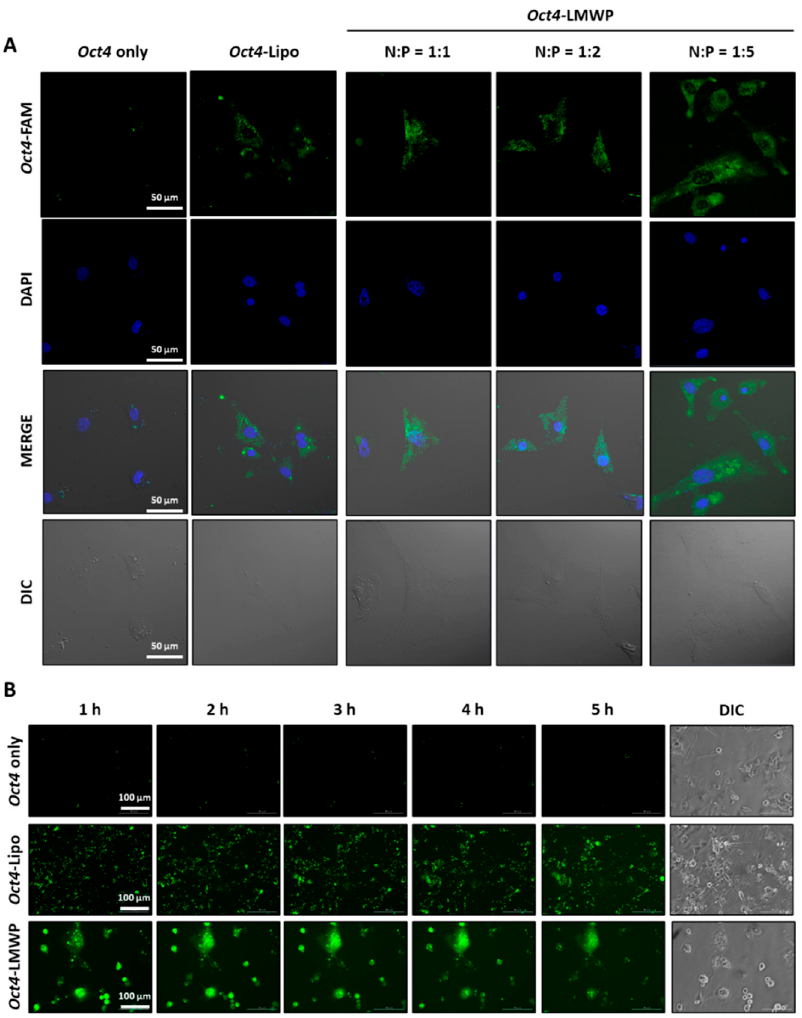
Figure 4. Intracellular uptake of Oct4 -LMWP. ( A ) The cellular uptake and intracellular localization of the Oct4 -LMWP complex were monitored at different molar ratios and analyzed using a confocal microscopy. Scale bar = 50 µ m. ( B ) Real-time detection of cellular uptake of Oct4 -LMWP complexes by MEF cells. Scale bar = 100 µ